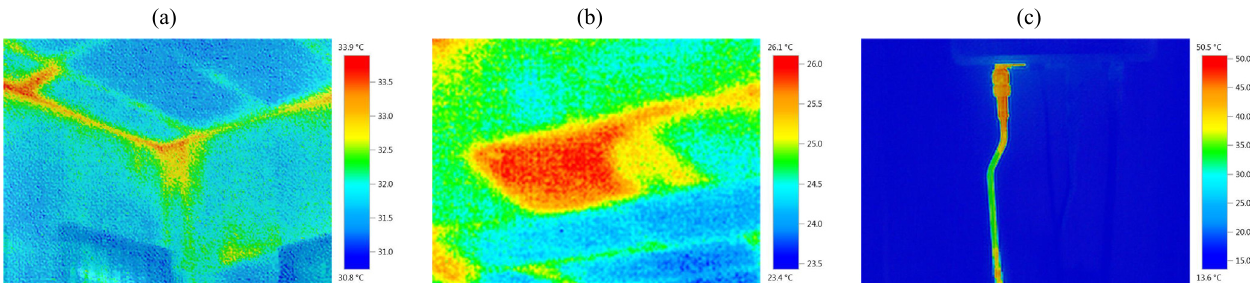
Fig. 5. Thermal images of (a) ceiling corners; (b) down lights and (c) hot water system